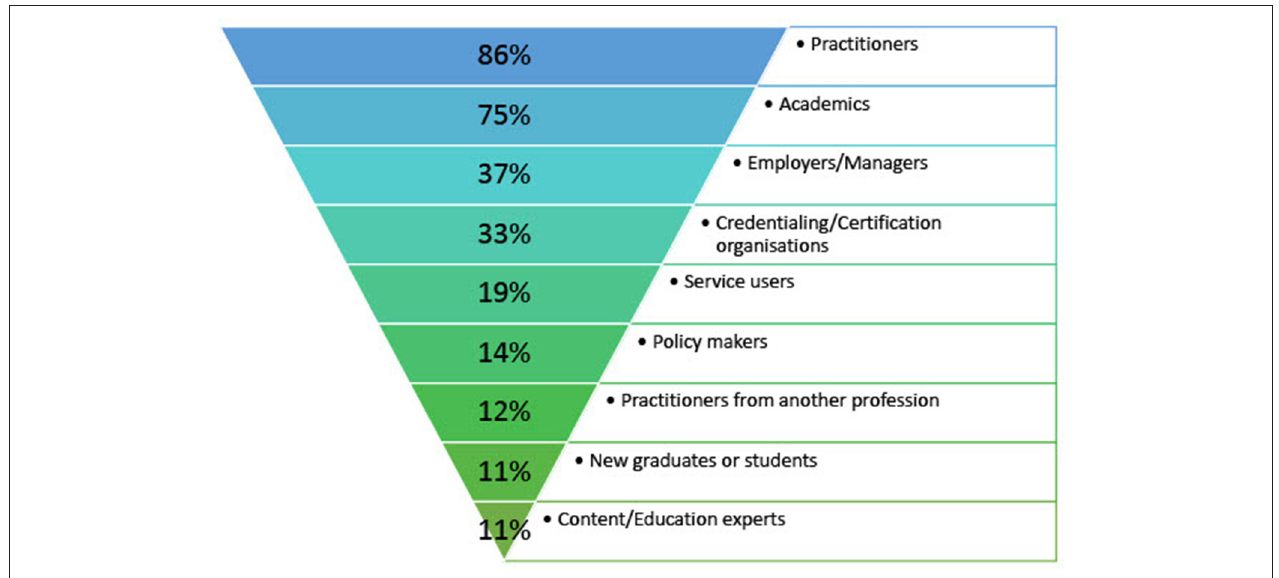
FIGURE 2 | Stakeholder engagement in competency framework development in health professions.